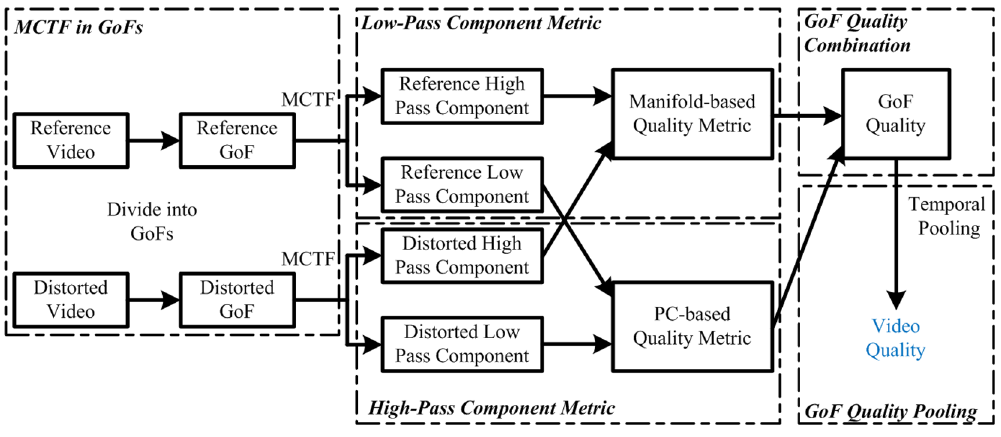
Fig 1. Framework for the proposed VQA